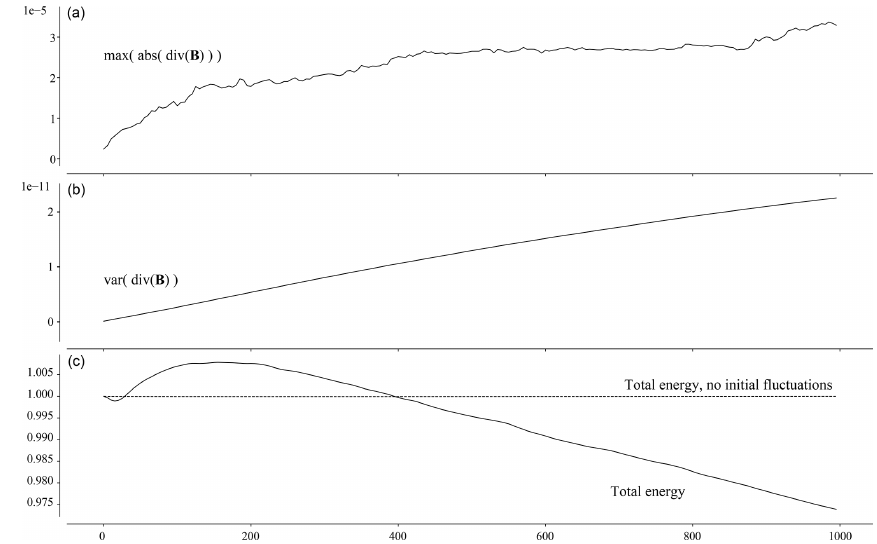
Figure B1. Time evolution of the maximum of the divergence of the magnetic field (a) and of the total energy (b) for the decaying turbulence